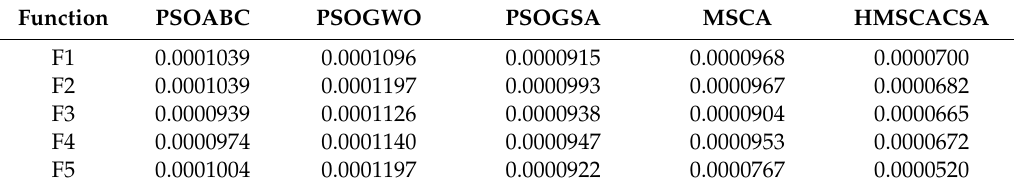
Table 5. Central Processing Unit (CPU) time for tested algorithms using standard benchmark functions.